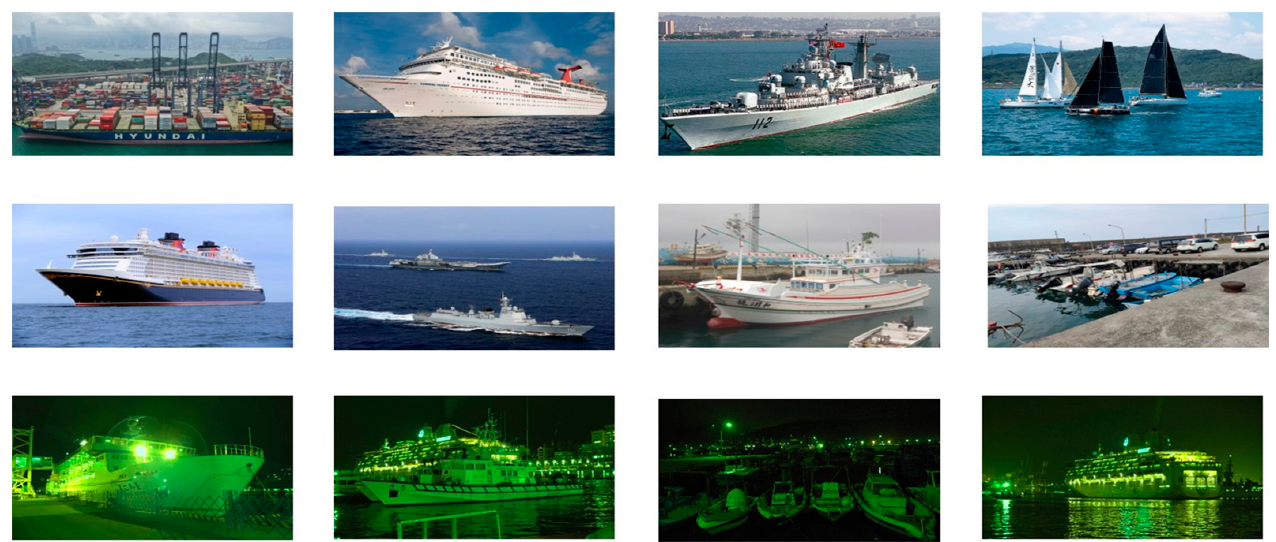
Figure 2. The samples of the data